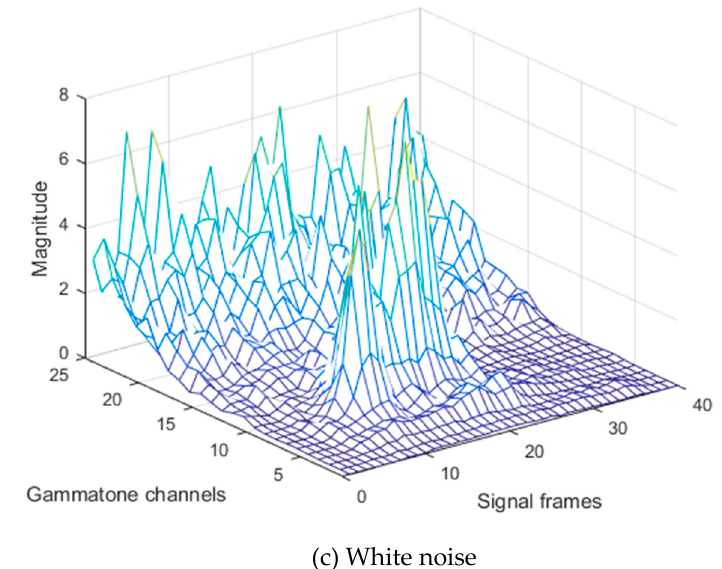
Figure 3. Gammatone spectrogram of the uttered word 'one'.